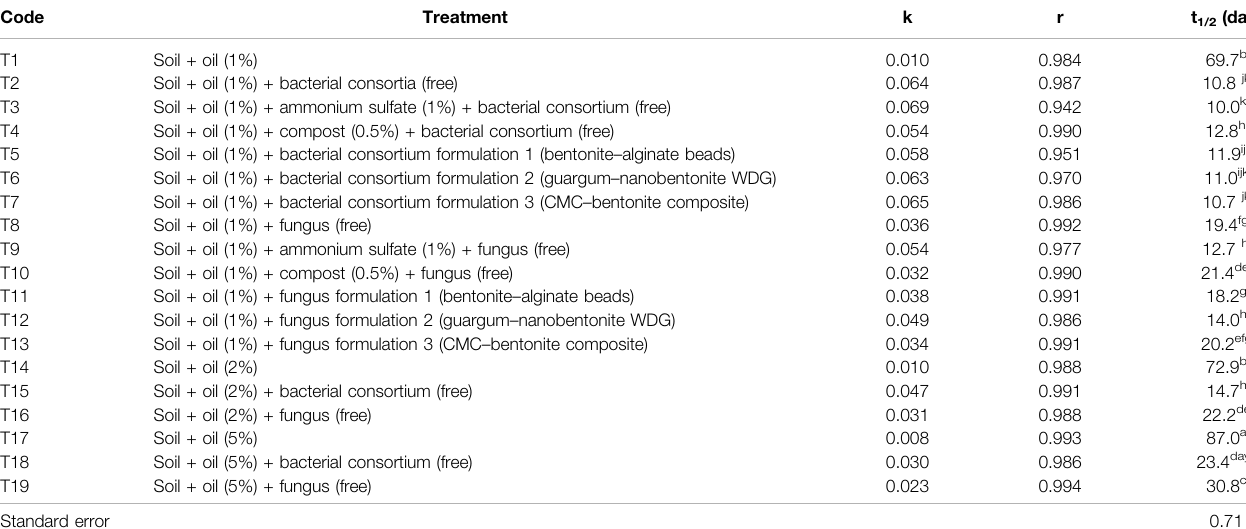
TABLE 2 | Degradation parameters, rate constant (k), coef fi cient of correlation (r), and half-life (t 1/2 ) for total petroleum hydrocarbons in the sandy loam soil. Code